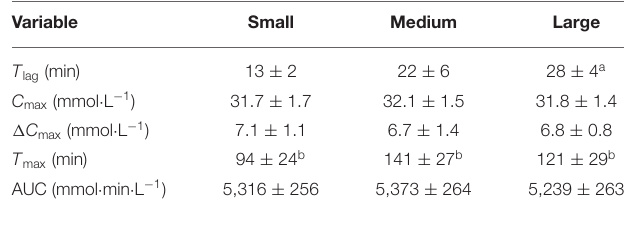
TABLE 1 | Mean (SD) bicarbonate kinetic variables following the consumption of 0.3 g · kg − 1 body mass NaHCO 3 in small-, medium-, and large-sized capsules.